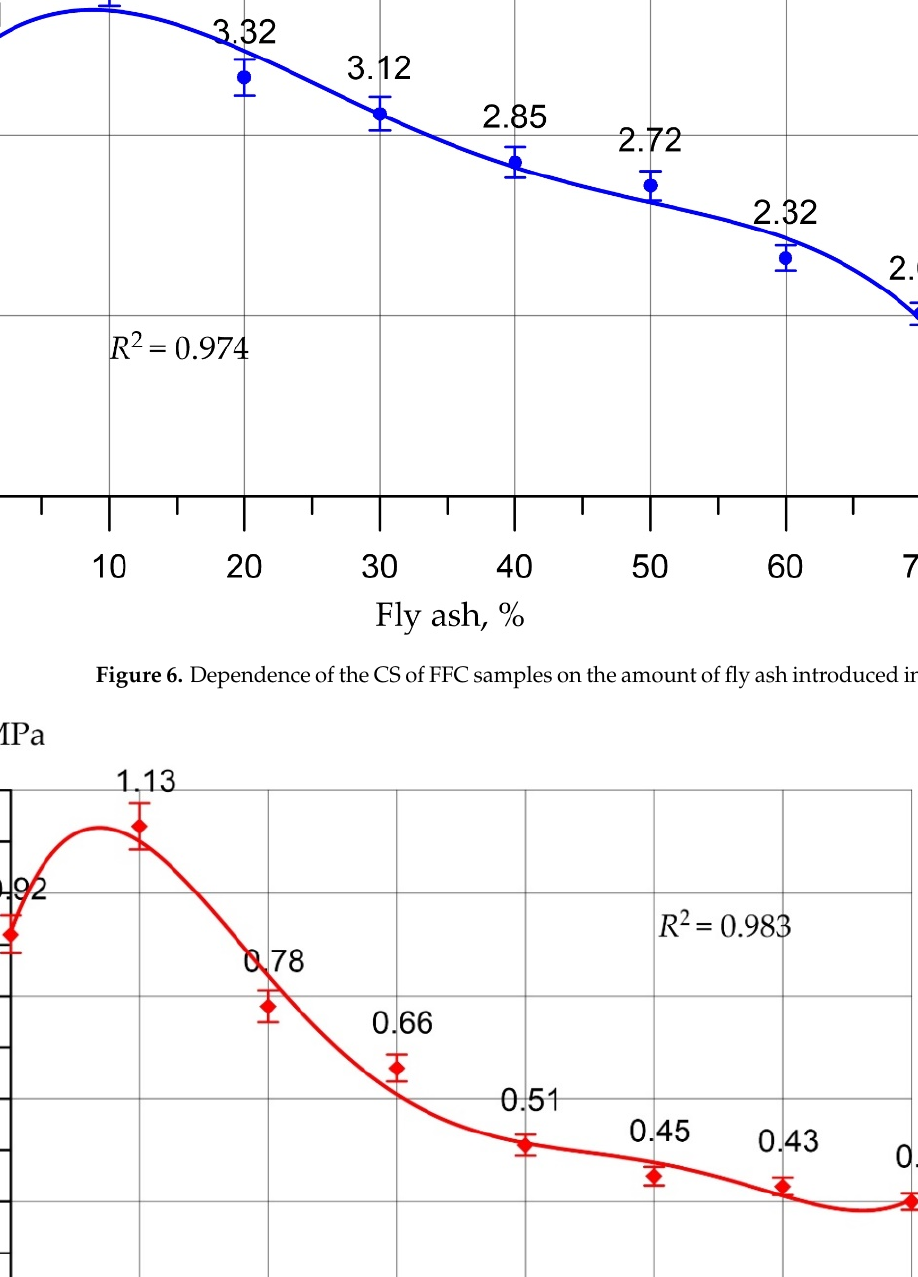
Figure 7. Dependence of the FS of FFC samples on the amount of FA introduced instead of ce- ment.